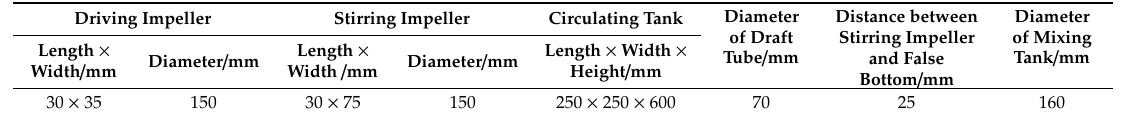
Figure 3. Schematic of the experimental system. Table 2. Structural parameters of the device.